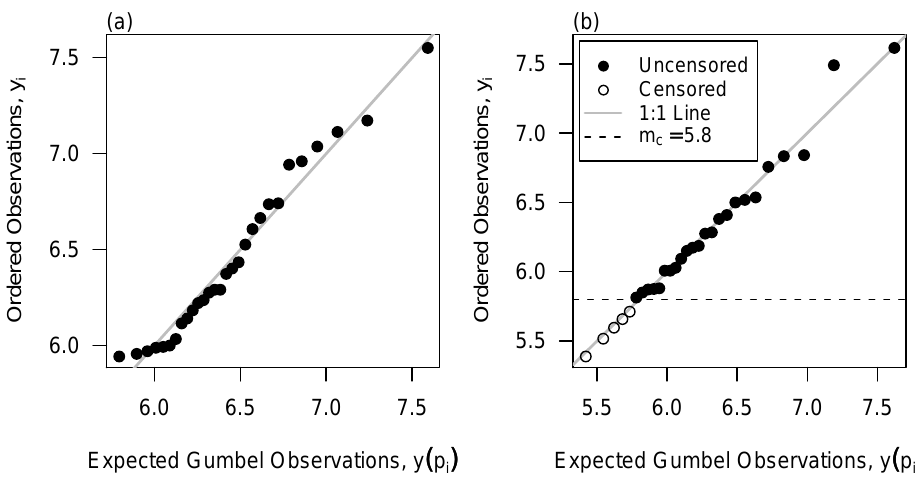
Fig. 1. (a) Gumbel probability plot using a complete series of n = 29 random Gumbel variates (Region 10) and (b) a censored Gumbel probability plot using the n = 29 Gumbel variates, with n − m = 24 uncensored observations and m = 5 left-censored values (Region